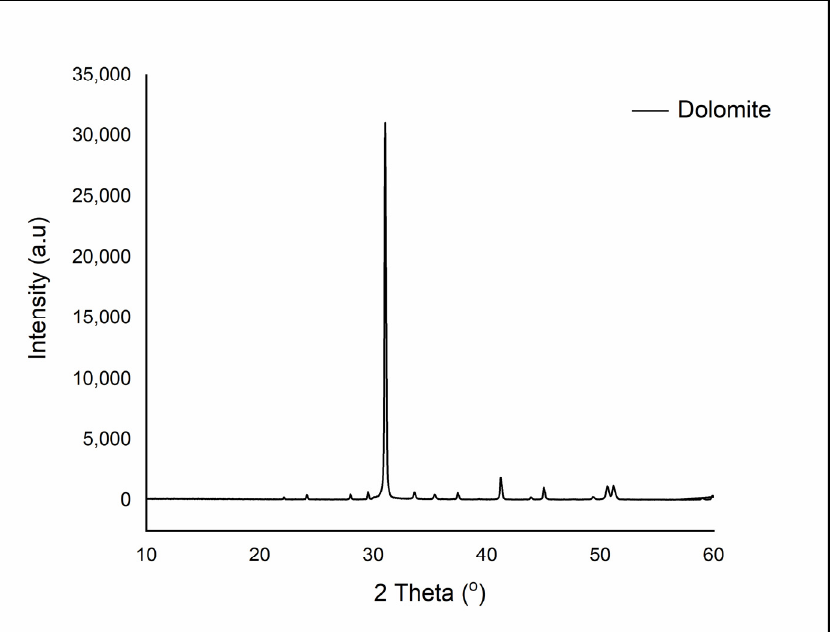
Figure 4. XRD diffraction graph of raw dolomite.